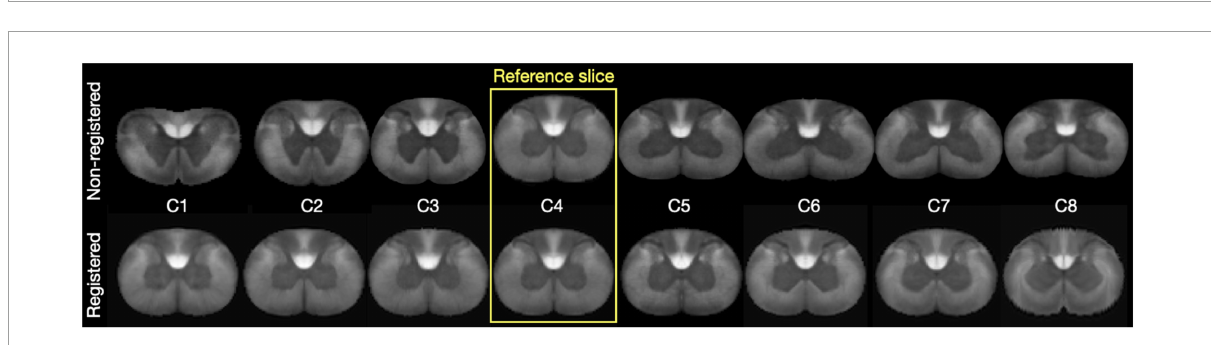
FIGURE5 (Top Row) Shows the individual slices for the cervical level for the metric map “Axon density”. The (Bottom Row) shows the registered levels. C4 was the reference slice for